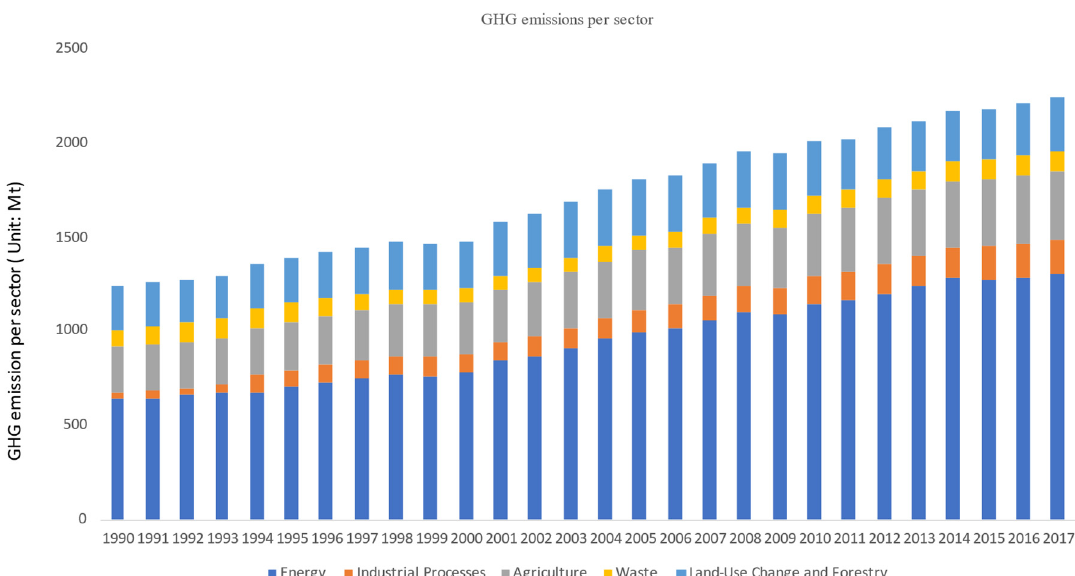
Figure 2. Historical GHG emissions by emitting sectors.